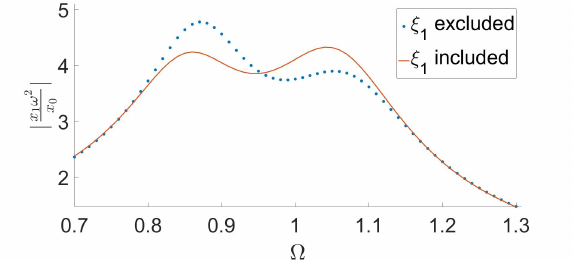
Figure 2. Improvement of TF 5 ( µ = 0 . 05, ξ 1 = 0 . 05) using desing formulas (2) and